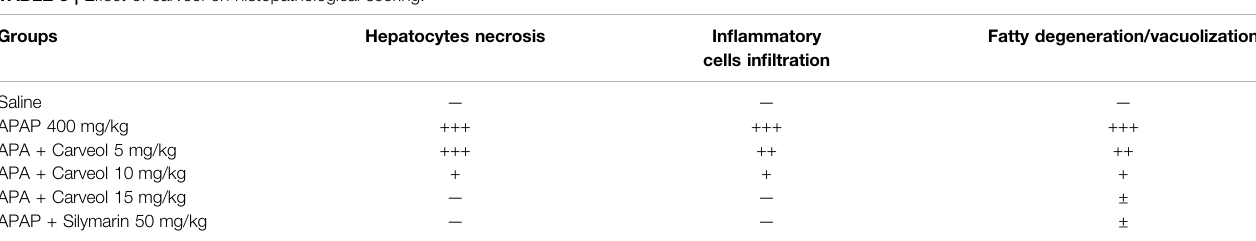
TABLE 3 | Effect of carveol on histopathological